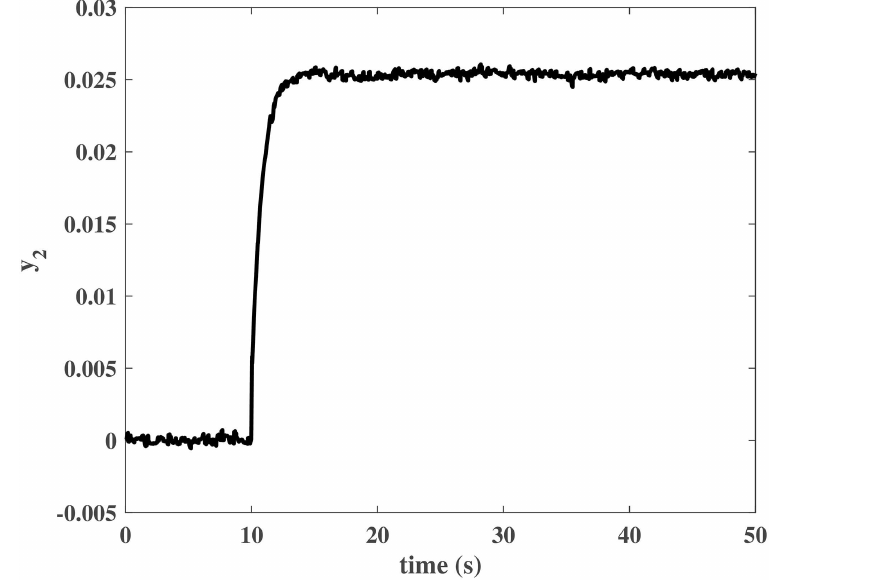
Fig 14. Response of y 2 in the HIL